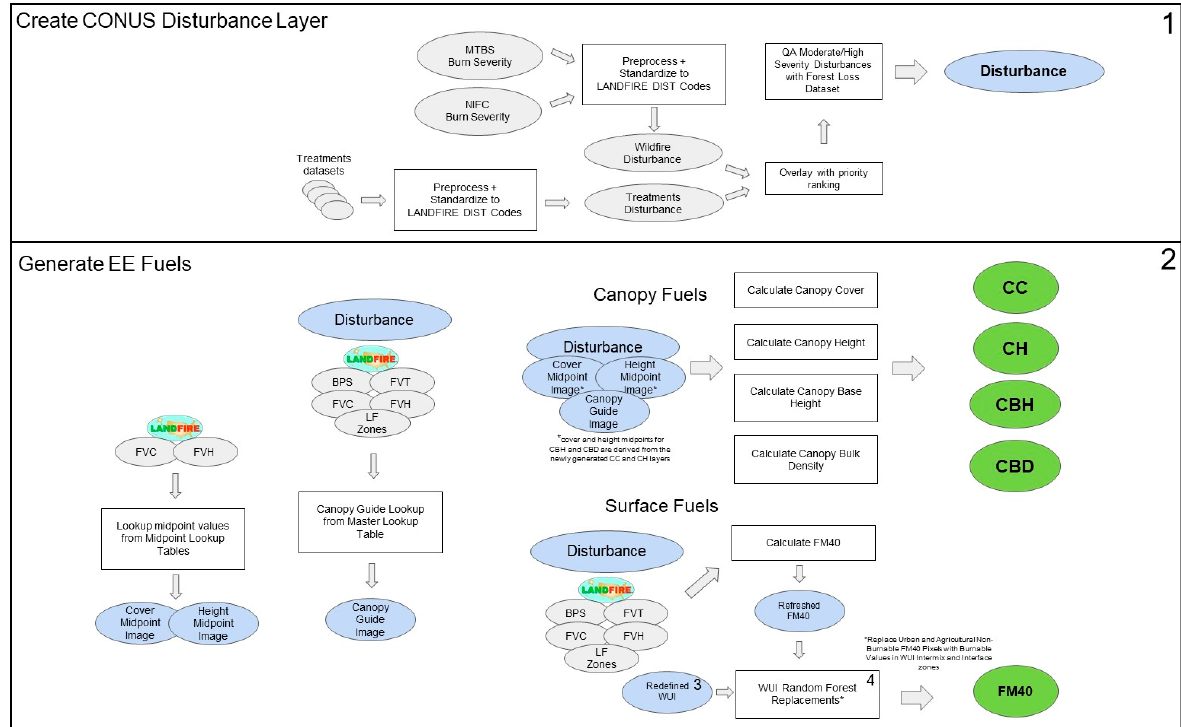
Figure 1. The modifications of the LANDFIRE v2.0.0 fuels (LF), including use of disturbance data (FVC—fuel vegetation cover; FVH—fuel vegetation height; FVT—fuel vegetation type; BPS—bio-